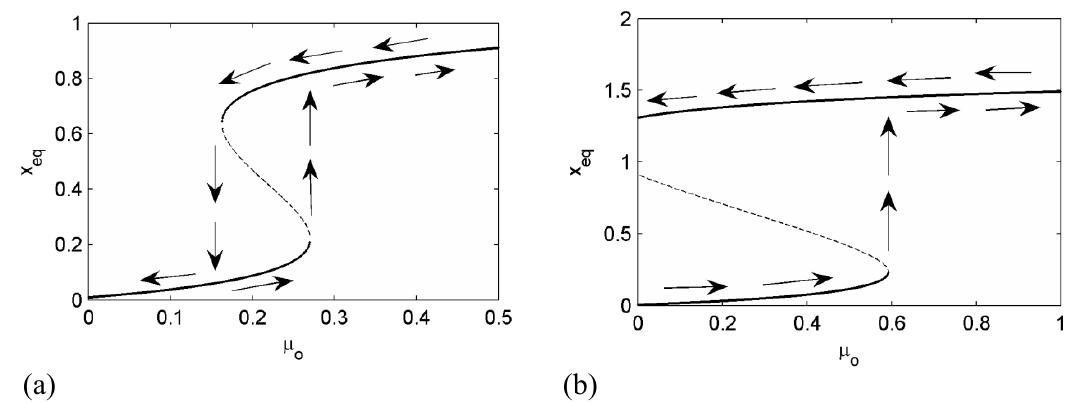
Appl. Sci. 2020 , 10 , x FOR PEER REVIEW Figure 13. Trajectories of a-a’ and b-b’ in Figure 10 at ( a ) Figure 13. Trajectories of a-a’ and b-b’ in Figure 10 at ( a ) θ o = 60